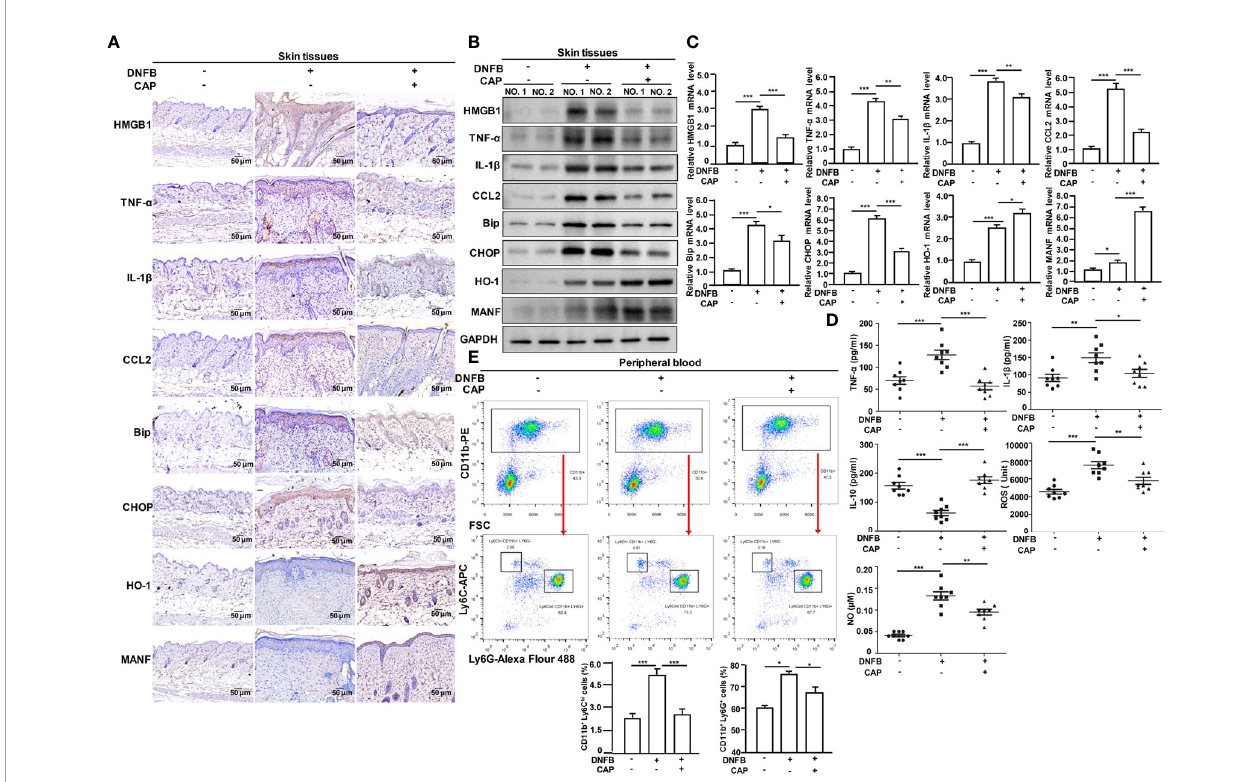
FIGURE 2 | CAP reduced DNFB-induced skin in fl ammation, ER stress and oxidative stress in mice. DNFB-induced AD mice model was constructed, followed by CAP treatment, n=8. Skin tissues (n=5) were used for immunohistochemical staining of HMGB1, TNF- a , IL-1 b , CCL2, Bip, CHOP, HO-1 and MANF (A) , as well as western blot (B) and RT-qPCR (C) of the indicated proteins. GAPDH serves as control for normalization. (D) Serum samples (n=8) were used for ELISA of TNF- a , IL- 1 b , IL-10, NO and ROS. (E) CD11b + Ly6C hi and CD11b + Ly6G + cells were examined by fl ow cytometry. Data are expressed as mean ± SEM. *p < 0.05, **p < 0.01, *** p <